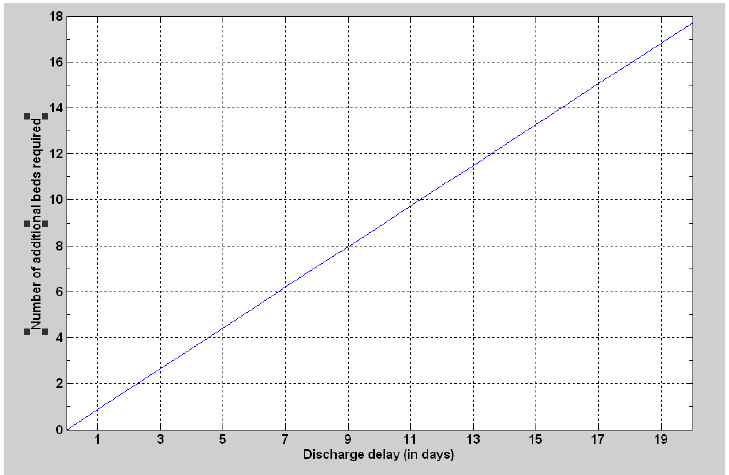
Figure 8. The estimated number of additional beds required in the stroke care unit with respect to the discharge delay (after 1000 days).